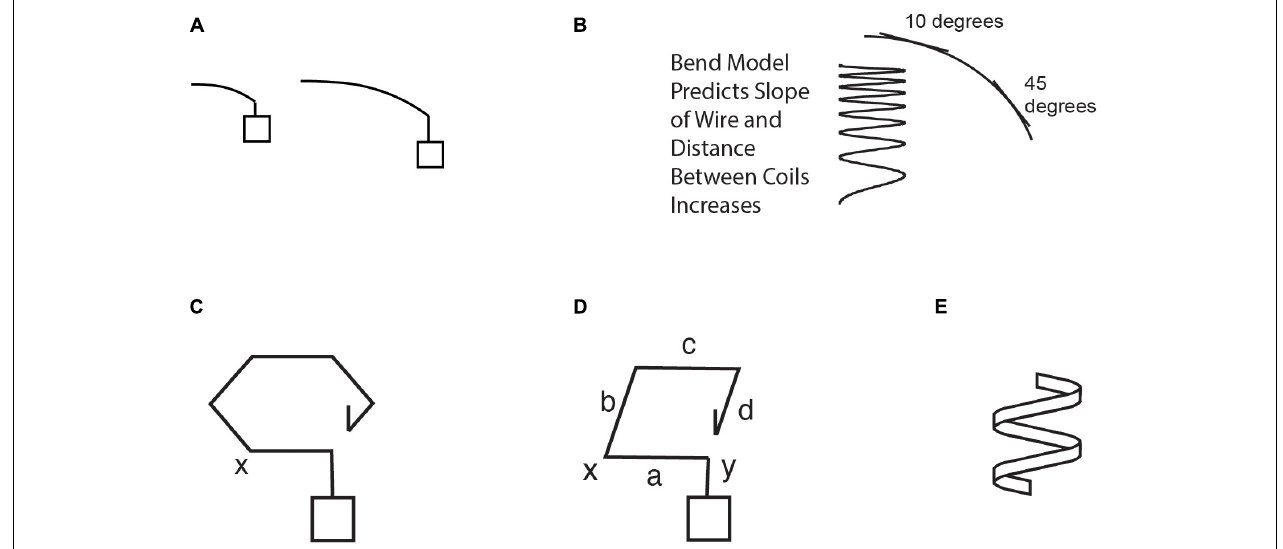
FIGURE 3 | Sequence of models considered by subject S2 that led to a conceptual breakthrough in Clement (2008). Bold capitalized type below signifies major Modeling Cycle Phases ; bold lower case signifies tactical heuristic reasoning processes . (A) S2 generated an analogy to long and short bending rods, and his mental simulation of the longer rod bending more implied that perhaps the wider spring would stretch more. (Panels A,C–E are redrawn from diagrams made by the subject.) (B) But using this analogy to Generate a Model of elements of the spring wire bending as it stretches leads him to Evaluate the model via a conflict with relevant observations: the slope of a bending rod increases along its length, and he infers this means the coils at the bottom would be farther apart, in panel (B) ; whereas he knows that real springs stretch uniformly with a constant slope in their coils and equal distance between coils, which become heeded constraints. (C) After a long period of struggling with this conflict, he simplifies to a single coil and thinks of Modifying the model by altering the rod into a hexagonal coil model. He then has a sudden AHA in inferring a new feature by mental simulation: that the forces in it will introduce a twisting effect in the wire, not just bending. He also applies a schema to the model (here the scientific concept of torsion). (D) Evaluating the hexagon as not simple enough , he Modifies the model by simplifying it into a square coil model. (He appears to imagine the situation in panel (D) as if side ‘a’ were a wrench acting at ‘x’ to twist the end of side ‘b’ through an angle, while side ‘c’ keeps the other end of ‘b’ from turning in the same direction, resulting in a twisting deformation of the metal in side ‘b’). Via mental simulation he then sees that bending and twisting ‘start over’ at each corner and do not accumulate in a square spring. This allows Evaluation of the model by explaining the relevant observation of the equal space between coils constraint, resolving the earlier anomaly for this case. He then Modifies the model further by inferring a new feature by mental simulation– that a wider square spring will stretch more, explained by its longer sides experiencing both more bending and more twisting, confirmed by an extreme case . (E) Later he negatively Evaluates the bending part of the model with a Gedanken (thought) experiment via mentally simulating a spring made of a band of metal that “can’t bend...but can easily twist” as it stretches, indicating bending is not necessary for stretching. Here, conducting a Gedanken experiment means attempting to mentally predict the behavior of an unfamiliar, concrete system (the “experiment”) designed to help evaluate a scientific model (Clement, 2009b). (This Gedanken is from a second interview simulating empirical input where S2 was told that measurements show that the primary deformation in the spring segments is a twisting or torsion effect as opposed to bending, and asked to provide a further explanation or argument for that.) See also Table 2 for condensed transcript of this entire